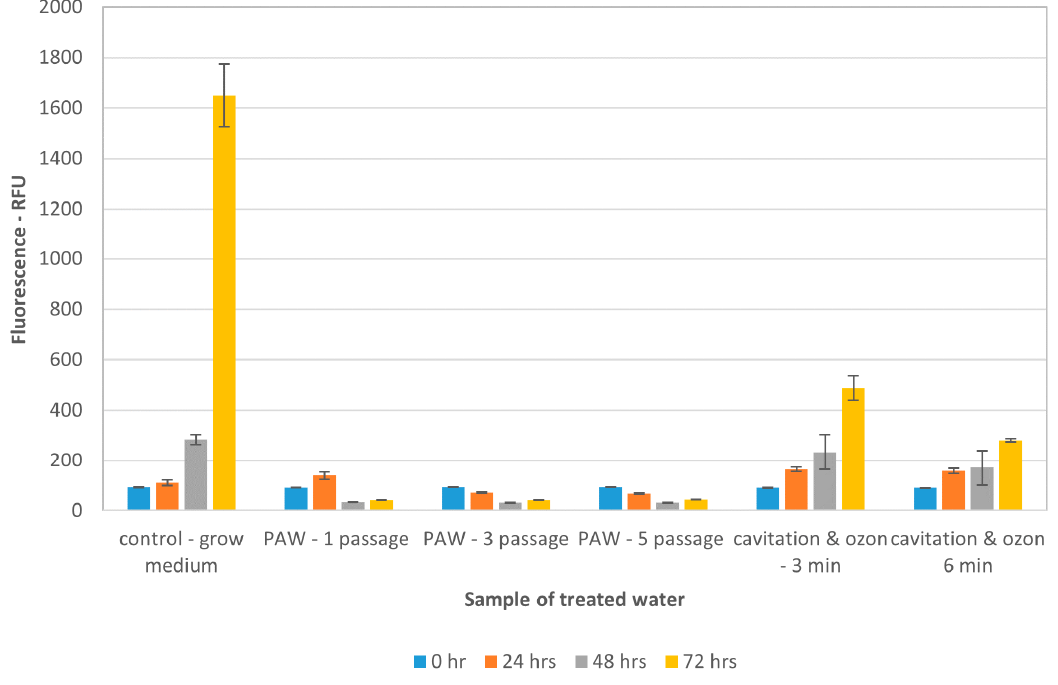
Figure 9. Growth test of cyanobacteria in water samples treated by HCPJ (PAW), and cavitation with ozonisation. Fluorescence measurements are given in relative fluorescence units (RFU).